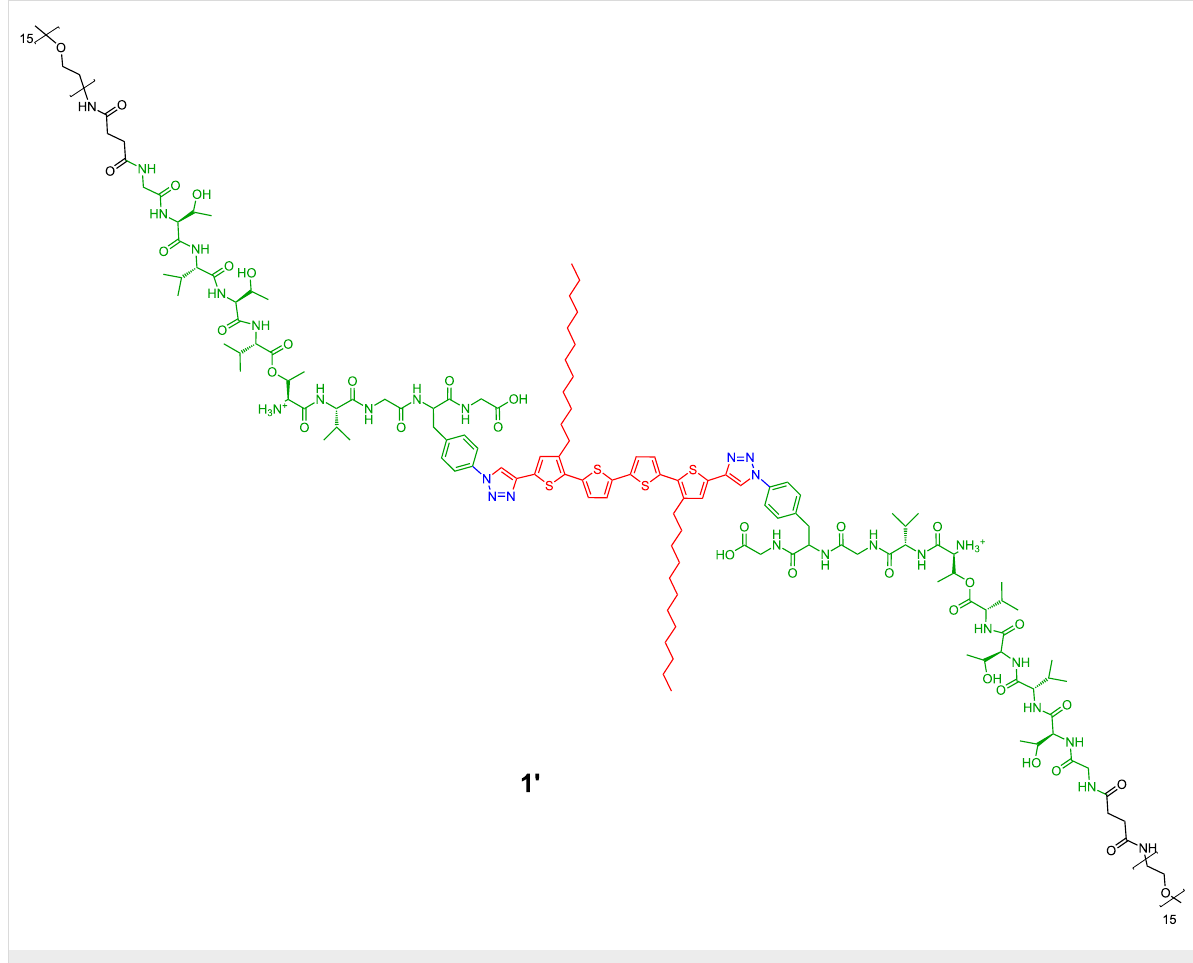
Figure 2: The A–B–A-type hybrid 1 in the deprotected, but still kinked, form 1'